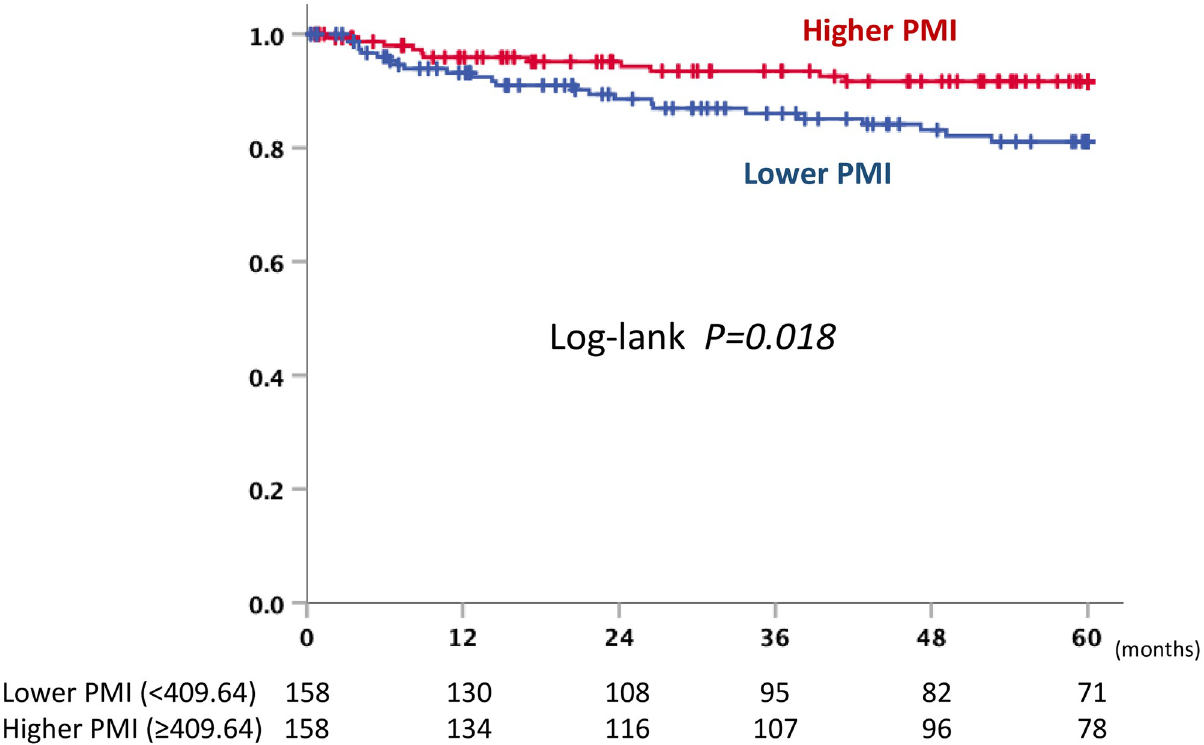
Fig 5. Recurrence-free survival curve within 5 years after nephrectomy in higher and lower PMI.